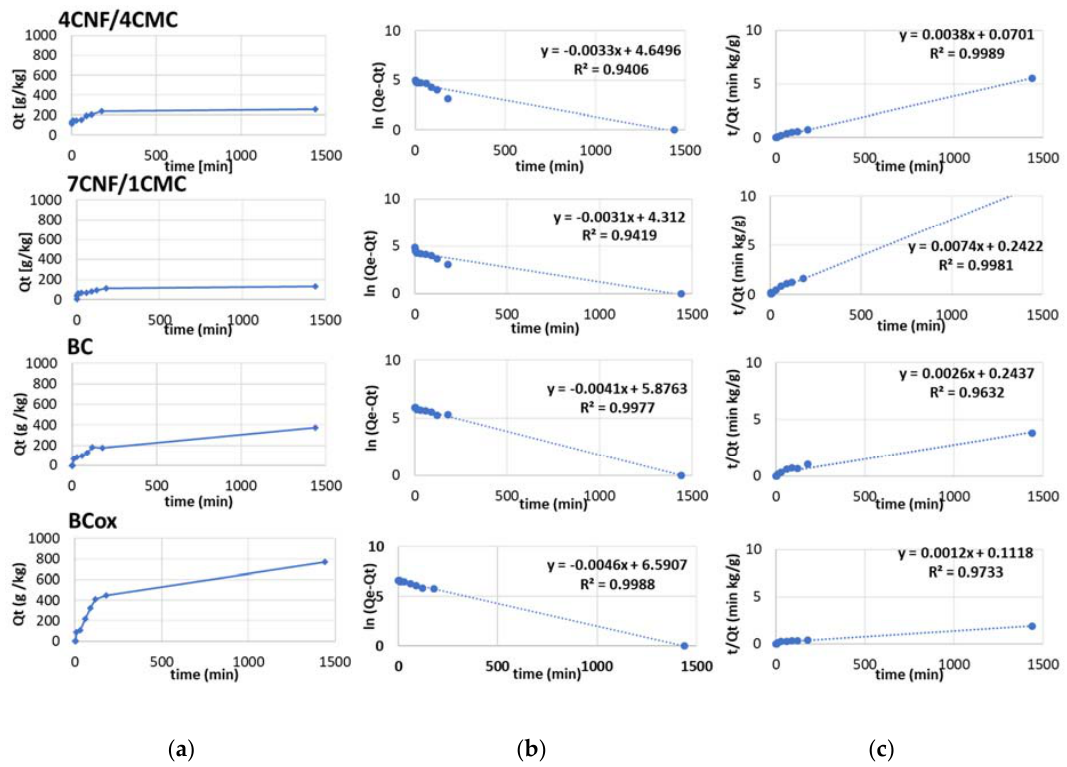
Figure 9. ( a ) Adsorption behavior of azo dye C.I. C.I. Basic Yellow 29, ( b ) pseudo-first-order kinetic plots, Figure 9 ( a ) Adsorption behavior of azo dye C.I. C.I. Basic Yellow 29, ( b ) pseudo ‐ first ‐ order kinetic plots, and ( c ) pseudo ‐ second ‐ order kinetic plots of 4CNF/4CMC, 7CNF/1CMC, BC, and BCox and ( c ) pseudo-second-order kinetic plots of 4CNF / 4CMC, 7CNF / 1CMC, BC, and BCox membranes.